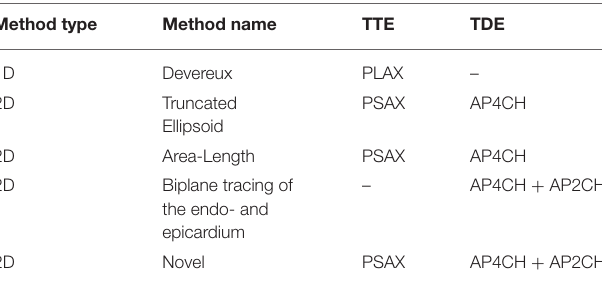
TABLE 1 | Methods for left ventricular mass